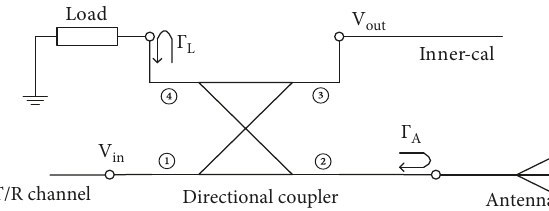
AntennaDirectional couplerT/R channel